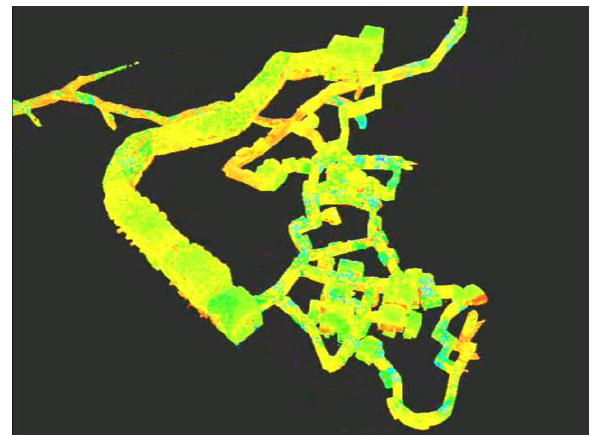
Fig. 9. TIN 3D model of the Kyiv Pechersk Lavra caves